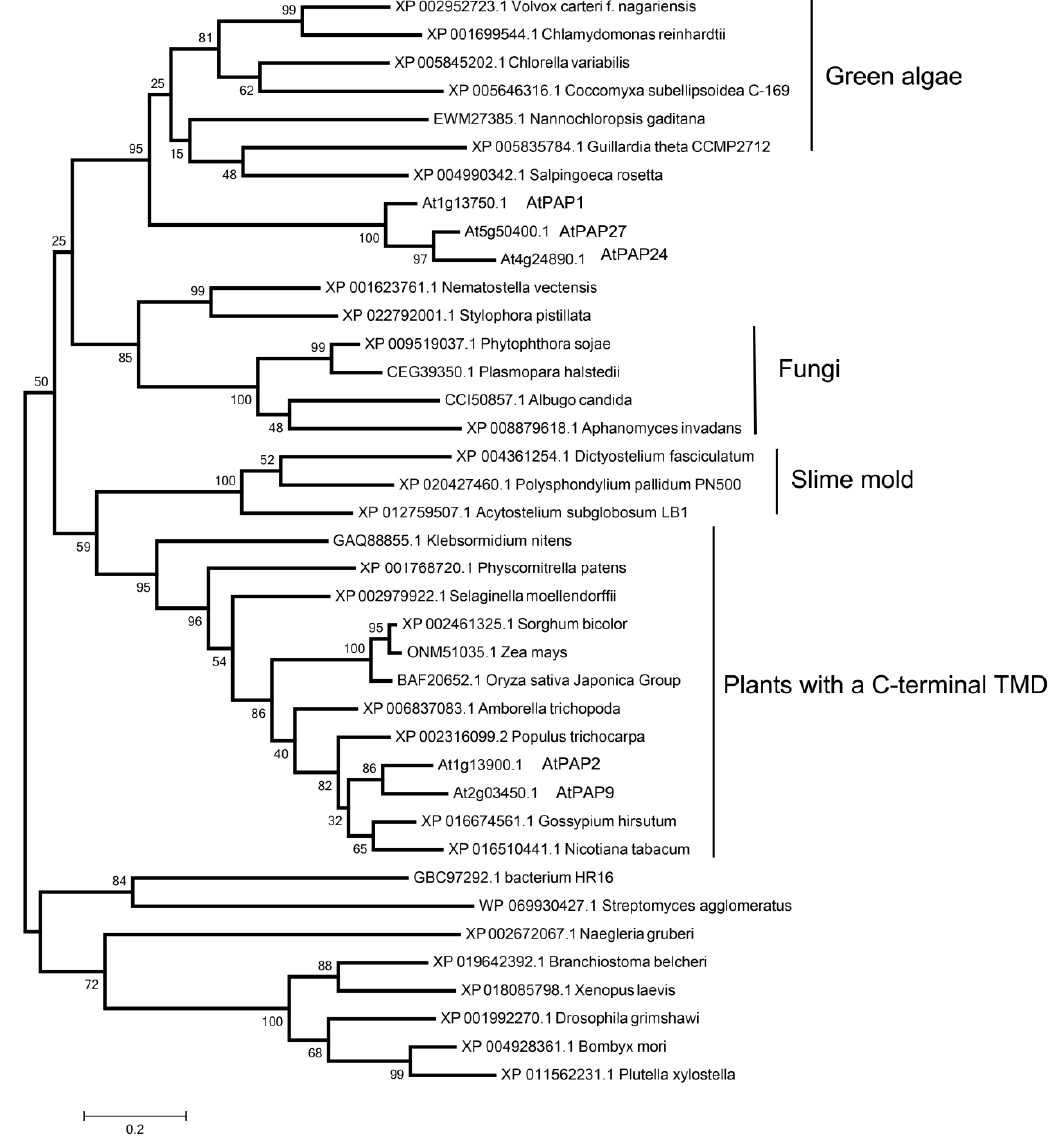
Figure 4. Phylogenetic analysis of AtPAP2 and its homologs in other species. Shown is a phylogenetic tree of AtPAP2, the 4 most related AtPAPs (AtPAP1, AtPAP9, AtPAP24 and AtPAP27), and PAP2 homologs in green algae, fungi, slime mold, and land plants. Bootstrap values at the corresponding nodes are based on 1000 bootstrapping replicates.